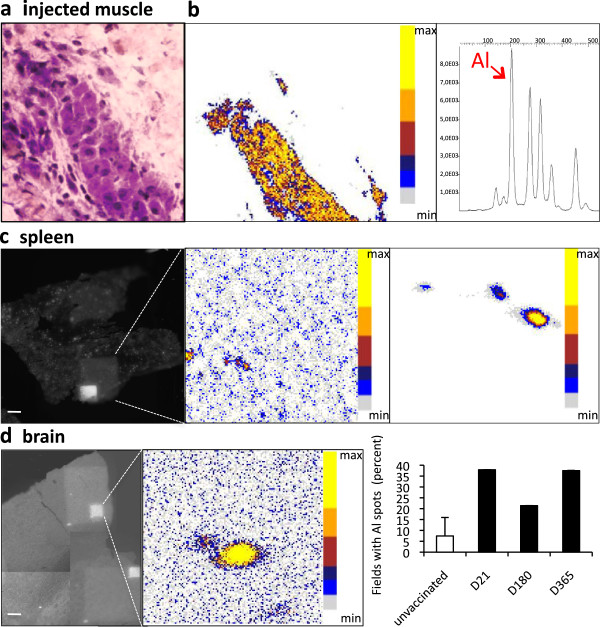
Aluminum deposits in tissues following injection of alum-containing vaccine in the TA muscle. a) Granuloma composed of PAS+ cells is formed in the injected muscle envelope; b) PIXE mapping shows muscle Al deposits in pseudocolors, with confirmatory Al emission spectrum (d21); c) Section of spleen tissue (left panel) displays the large 500 × 500 μm and restricted 100 × 100 μm protonized fields corresponding to the PIXE maps (middle and right panel, respectively) enclosing eligible Al spots (d21); d) Section of brain tissue (left left panel) displays the restricted 100 × 100 μm protonized field corresponding to the PIXE map (middle panel) enclosing eligible Al spot (d21); the number of fields containing one or more Al spots was increased at all tested time points compared to unvaccinated (right panel) mice. (bars: 100 μm). d, day; PIXE, particle induced X-ray emission, TA tibialis anterior.